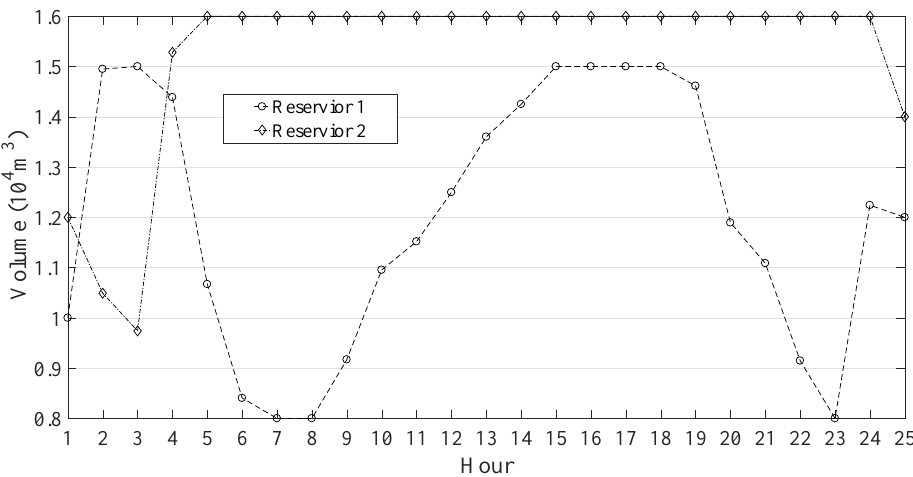
Figure 3. The reservoir volumes of the pumped hydro